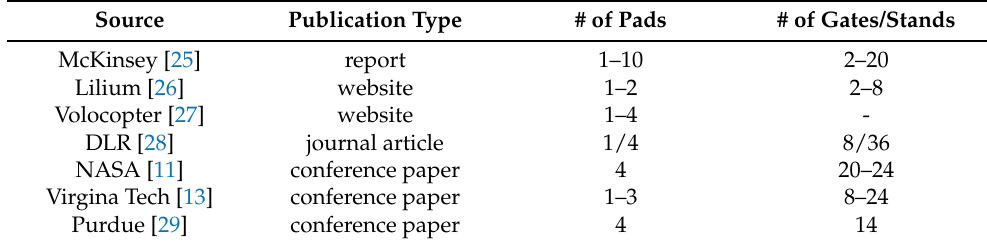
Table A1. Review of vertiport